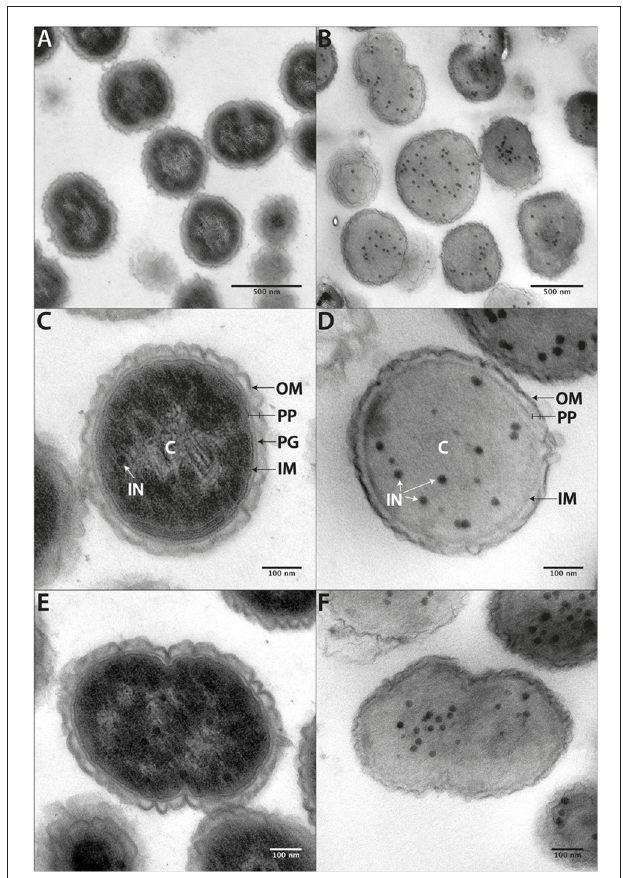
FIGURE 6 | Cell ultrastructure. Ultrathin sections of chemically fixed (A,C,E) or high-pressure frozen (B,D,F) V. parvula cells. At higher magnification the inner membrane (IM), the peptidoglycan (PG) containing periplasm (PP), and the slightly waved outer membrane (OM) become apparent. In chemically fixed cells, an electron brighter area within the periplasm most likely represents DNA. Electron dense circular structures (IN) can be seen within the homogenous cytoplasm of high-pressure frozen cells and, to a less extent also in chemically fixed cells.